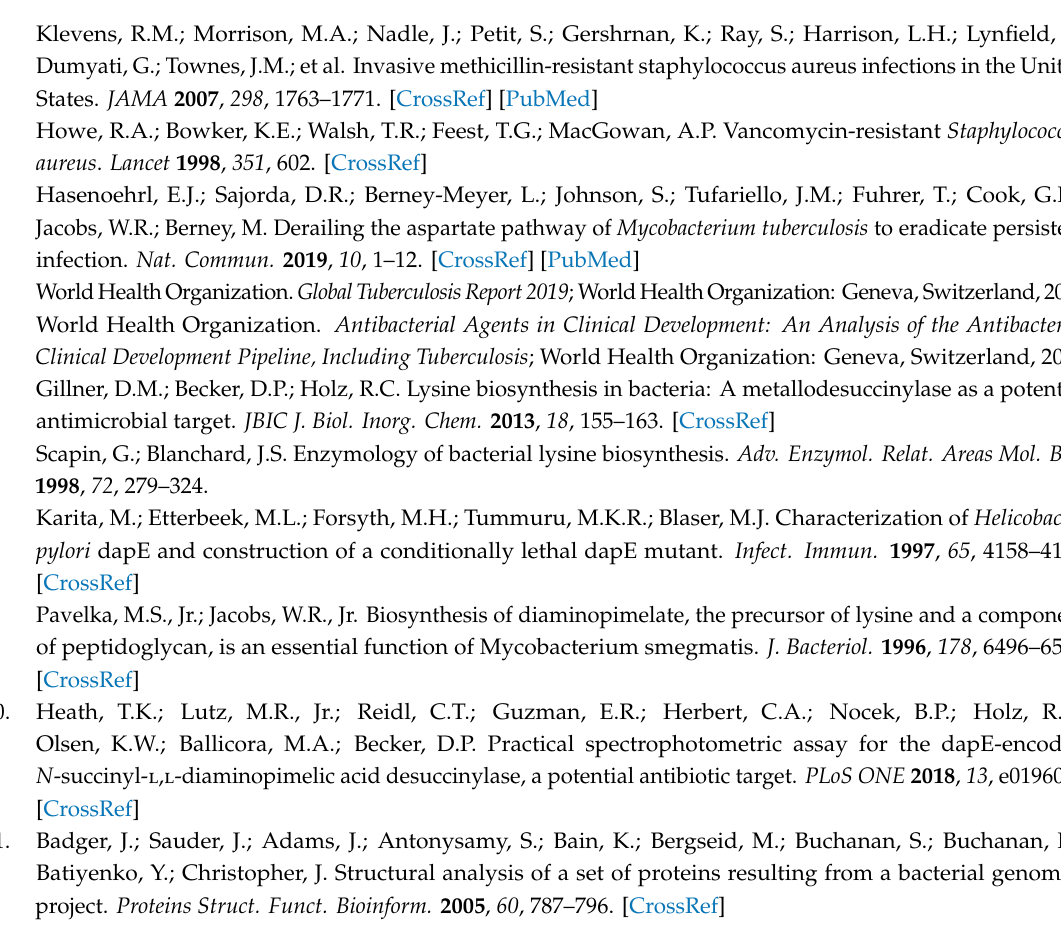
Figure S1: copies of spectral characterization of compounds 4 , 7b , 8a , 8b , 9a – n , and 10a – f